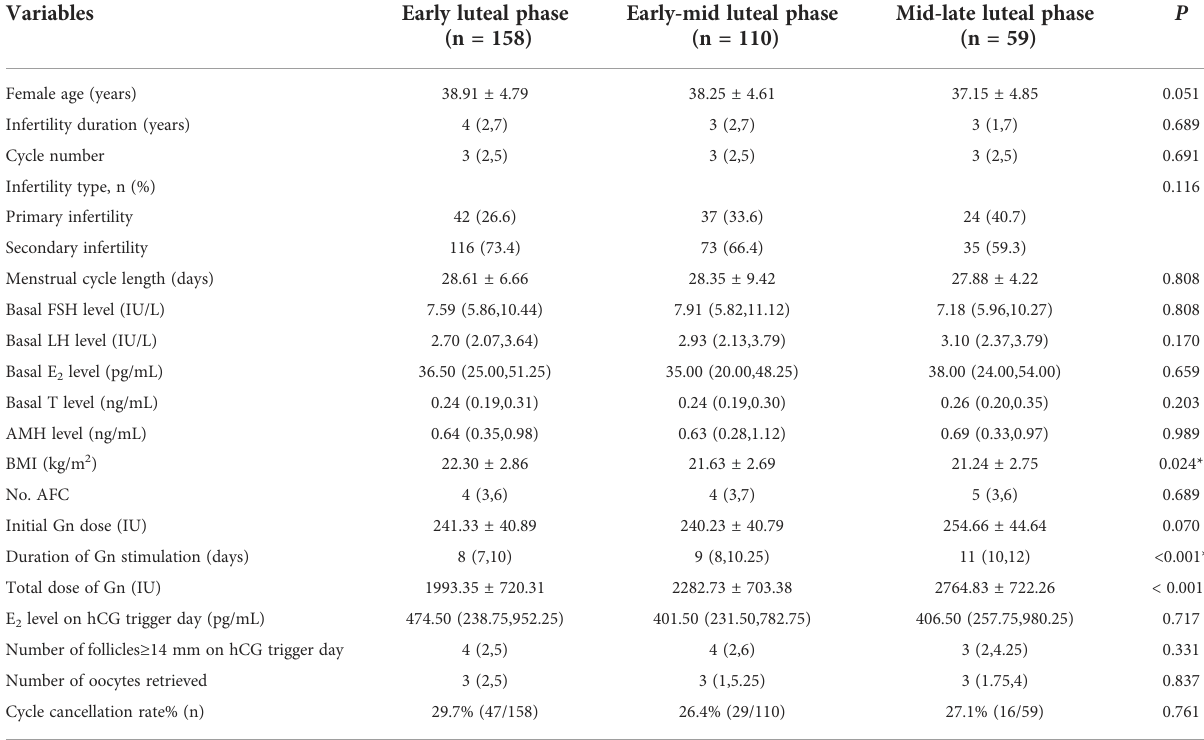
TABLE 1 Baseline characteristics and ovarian response in groups with different gonadotropin (Gn) initial